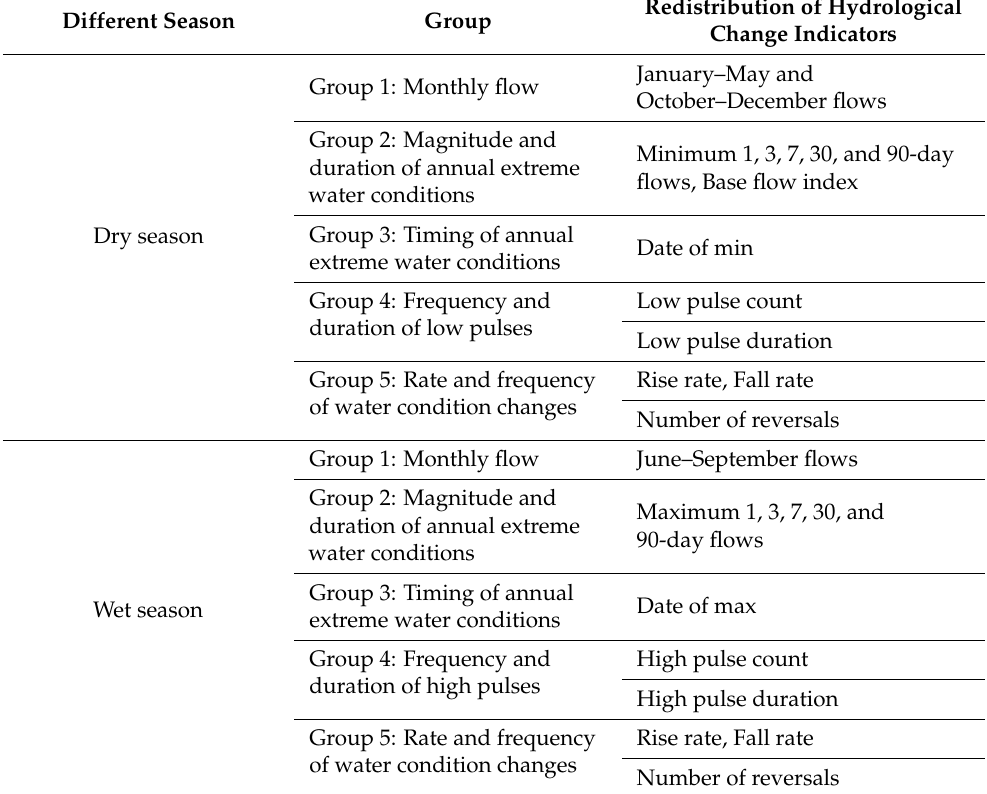
Table 3. Refined IHA